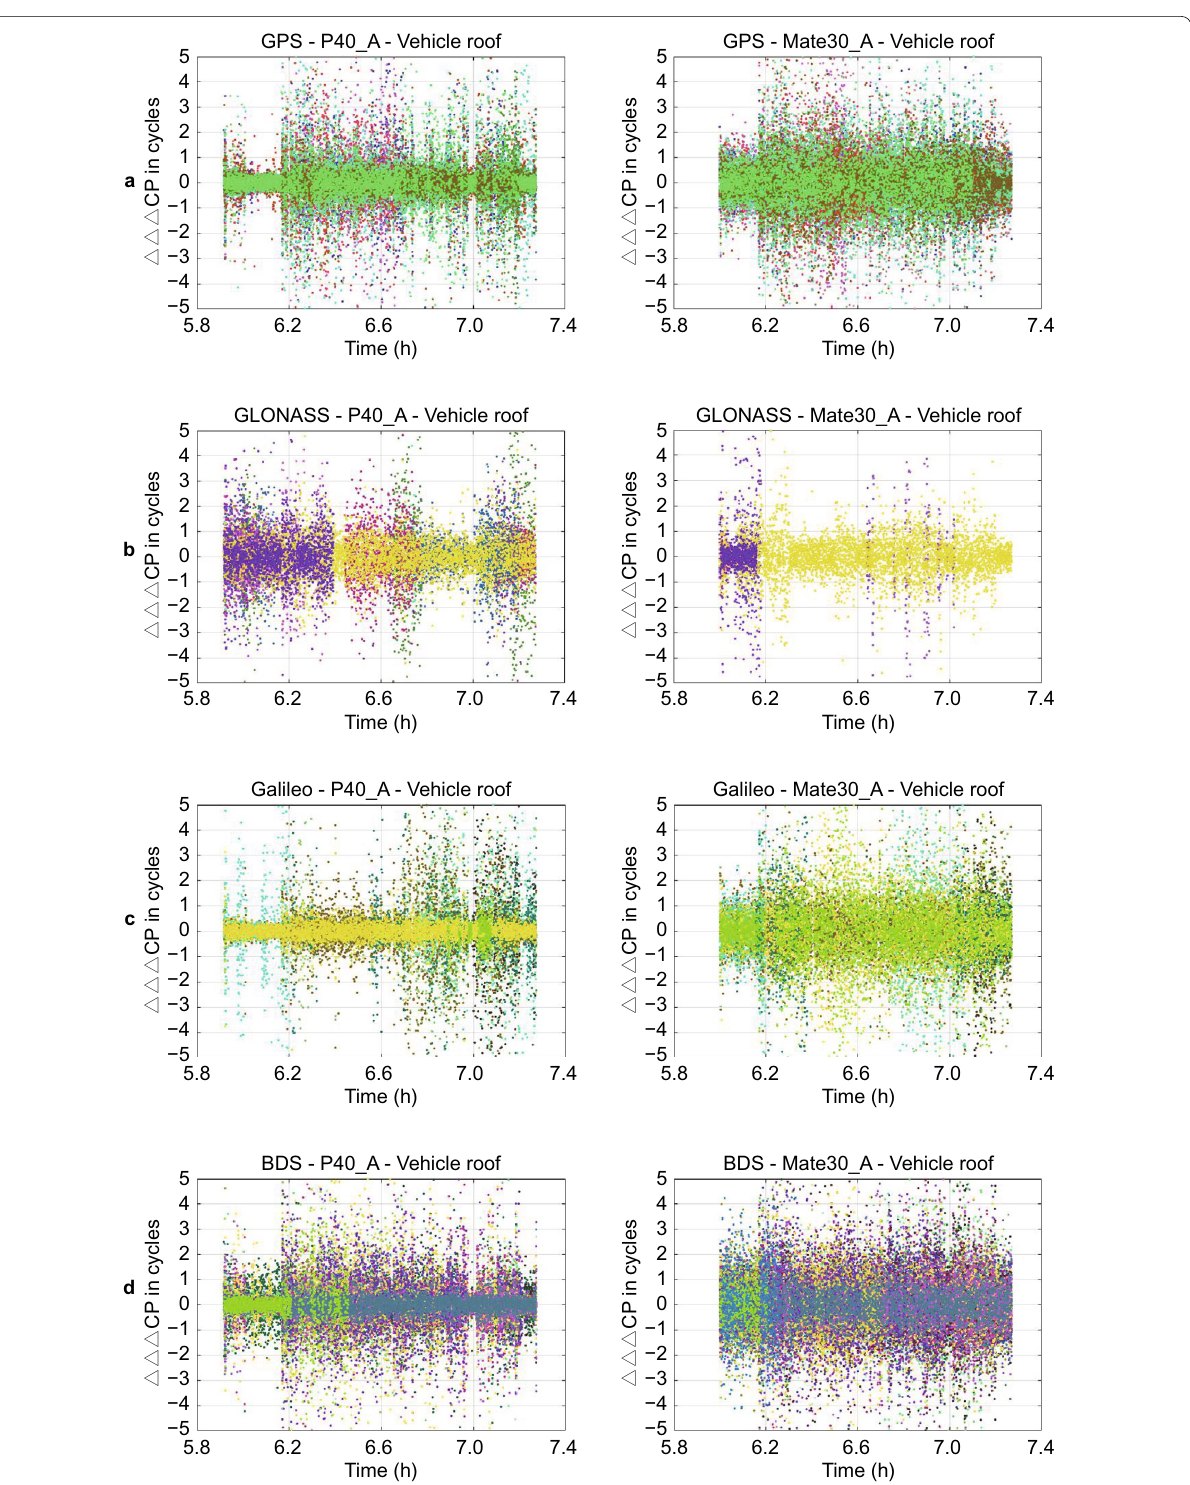
Fig. 7 Time series of triple differences of carrier phase (denoted by ΔΔΔCP) results of a GPS L1, b GLONASS L1, c Galileo E1, and d BDS B1I for the P40_A and Mate30_A experimental smartphones in the vehicle-roof